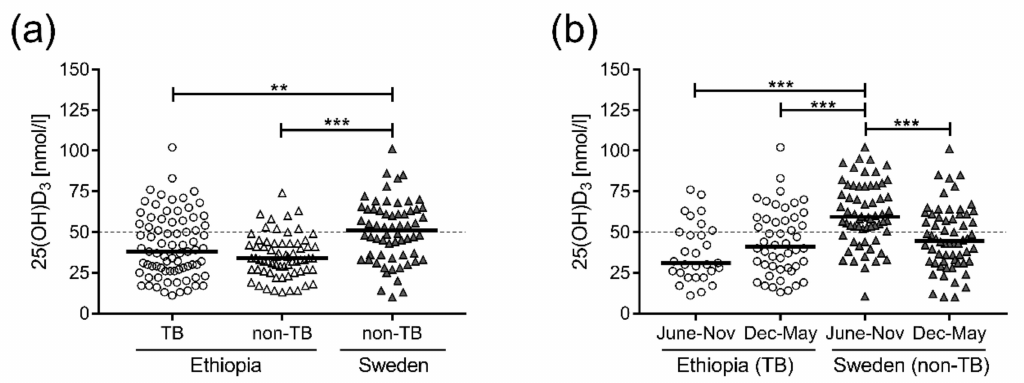
Figure 1. VitD 3 levels in patients with active TB compared to non-TB control